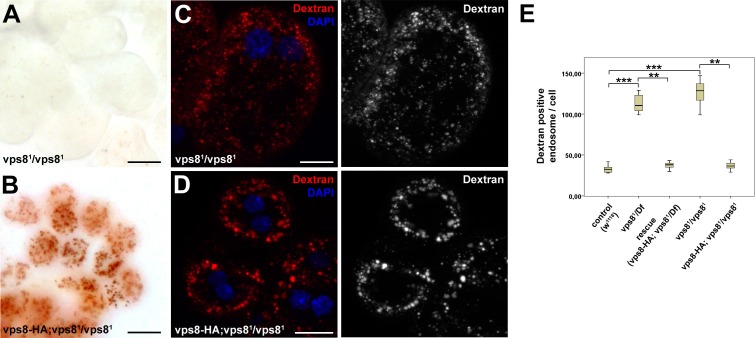
Loss of Vps8 impairs endocytic trafficking in garland nephrocytes and hemocytes.(A,B) Garland nephrocytes from homozygous vps81 mutants contain practically no detectable silver inclusions (similar to vps81/Df animals shown in Figure 4B), and this effect can be rescued by the vps8-HA transgene. (C,D) The fluorescent dextran uptake phenotype of homozygous vps81 mutant garland nephrocytes is similar to vps81/Df cells shown in Figure 4E. The phenotype can be rescued with the vps8-HA transgene. (E) Quantification of the number of dextran positive endosomes/cell from panels (C,D) and Figure 4D–F. The medians of data are indicated as vertical black lines within the boxes. Bars show the upper and lower quartiles, **p<0.01, ***p<0.001. Bars: (A,B): 20 µm, (C,D): 10 µm.